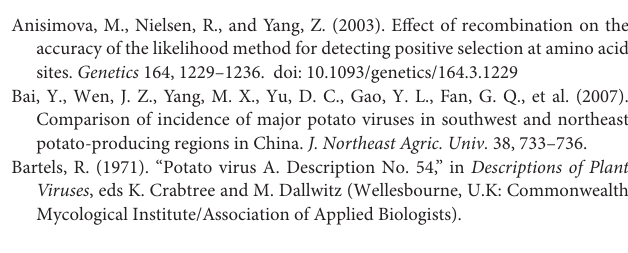
Supplementary Table 2 | Isolates of potato virus A used in this study. Supplementary Table 3 | Genetic diversity parameter estimates for difference protein coding regions gene in the genome of potato virus